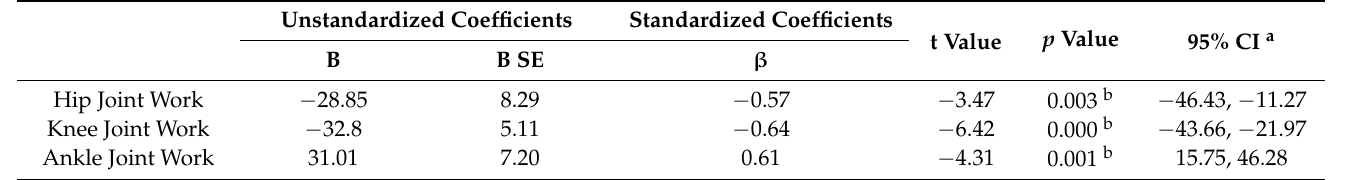
Table 3. Multiple regression analysis of joint works in the lower extremity during the deceleration and take-off phase of landing (R 2 = 0.74, adjusted R 2 = 0.70). Unstandardized Coefficients Standardized